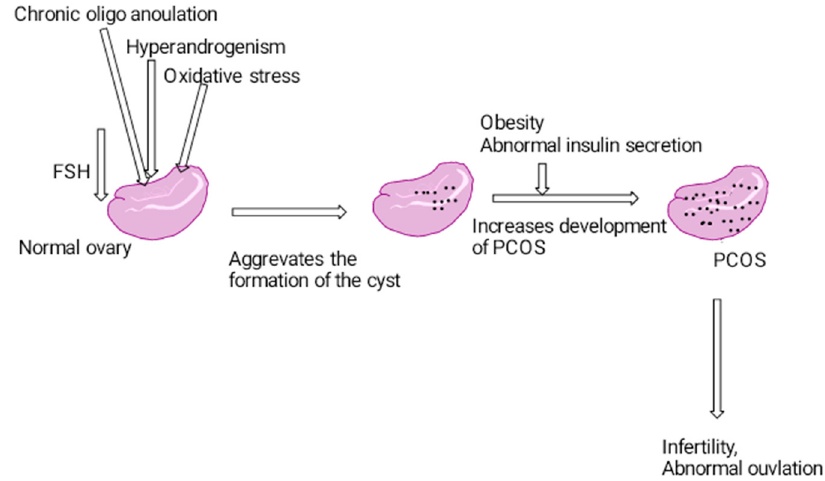
Figure 2. Pathogenesis of polycystic ovarian syndrome.